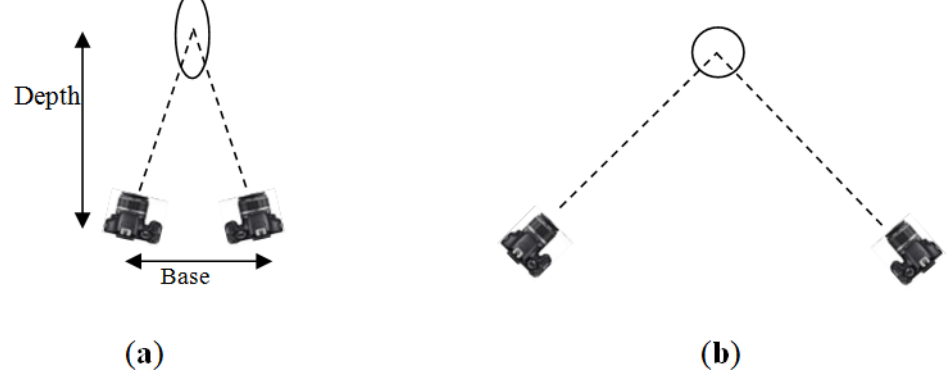
Figure 2. Intersection geometry and error plot. ( a ) Weak intersection with small base\depth ratio; ( b ) Strong intersection with large base\depth